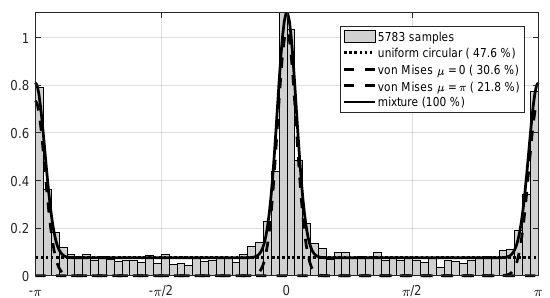
Figure 4. Histogram of the edge directions with 64 bins and es- timated distributions of the mixture model with two von Mises distributions and the uniform circular distribution modeling the background clutter (“2+1 model”).